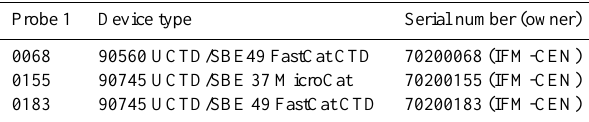
Table 3. UCTD sensors used.